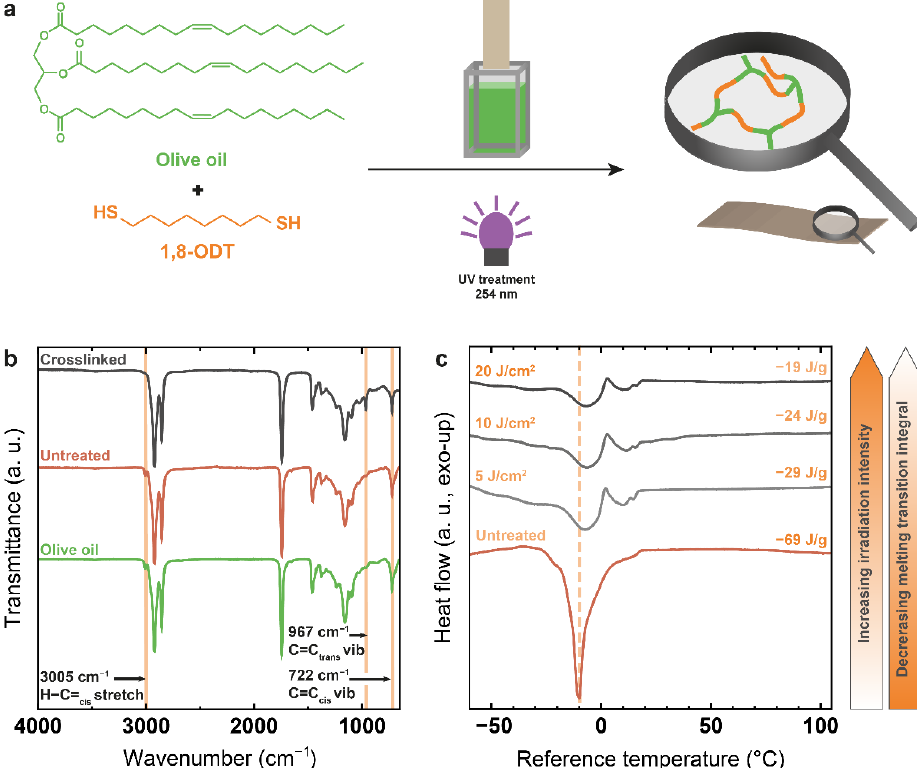
Figure 4. ( a ) Reaction scheme for thiol-ene reaction of olive oil with 1,8-ODT; ( b ) comparison of the FTIR spectra of fresh olive oil, the untreated olive oil/1,8-ODT mixture and the crosslinked mixture; ( c ) DSC curves of the olive oil/1,8-ODT mixture before and after crosslinking with different UV intensities showing decreasing integrals for the combined melting transitions. 1 H-NMR spectroscopy (Figure S1) revealed the olive oil batch used contained 3.03 C=C double bonds per triglyceride, as calculated from olefinic and methyl proton signal